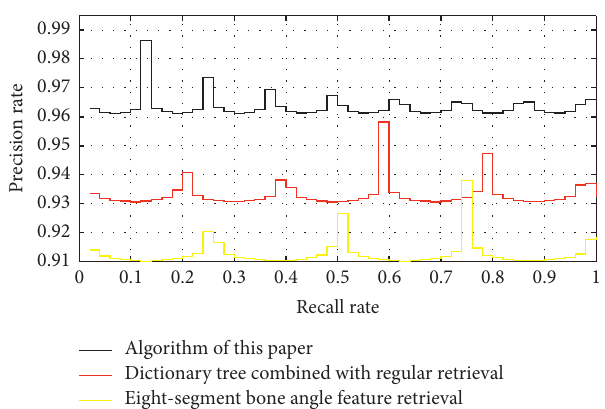
Algorithm of this paper Dictionary tree combined with regular retrieval Eight-segment bone angle feature retrieval Figure 11: P-R comparison of search results of multiple methods on several different sports categories.